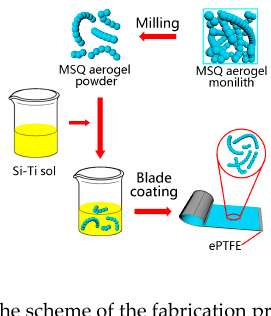
Figure 2 . ( a ) The fabrication process for an MSQ aerogel coating layer on Polytetrafluoroethylene (ePTFE) thin film; ( b ) a digital photo of the fabricated large-scale MSQ aerogel coating on ePTFE thin film.